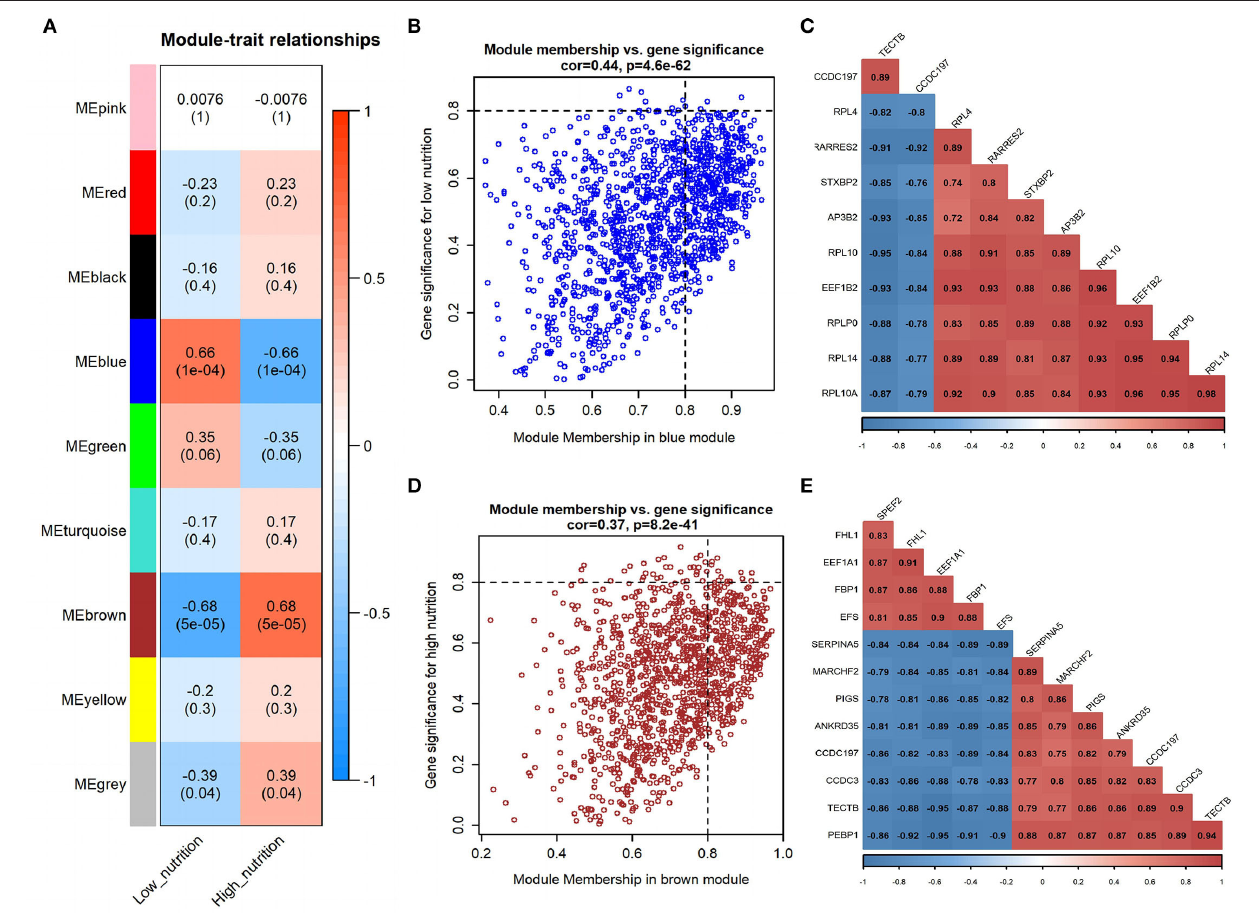
FIGURE 2 | Module-trait correlations analysis in visceral adipose tissue (PRJNA664093). (A) Correlation heatmap between modules and nutrition levels. The correlation coefficient and P -value are labeled in the rectangle. (B) The MM and GS for low nutrition in the blue module. The dots represent genes in the blue module, the horizontal axis is the MM value, and the vertical axis is the GS value for low nutrition. (C) The correlation relationship of the top 10 genes with high MM and GS in the blue module. The correlation coefficients are labeled in the rectangle. (D) The MM and GS for high nutrition in the brown module. The dots represent genes in the brown module, the horizontal axis is the MM value, and the vertical axis is the GS value for high nutrition. (E) The correlation relationship of the top 12 genes with high MM and GS in the brown module. The correlation coefficients are labeled in the